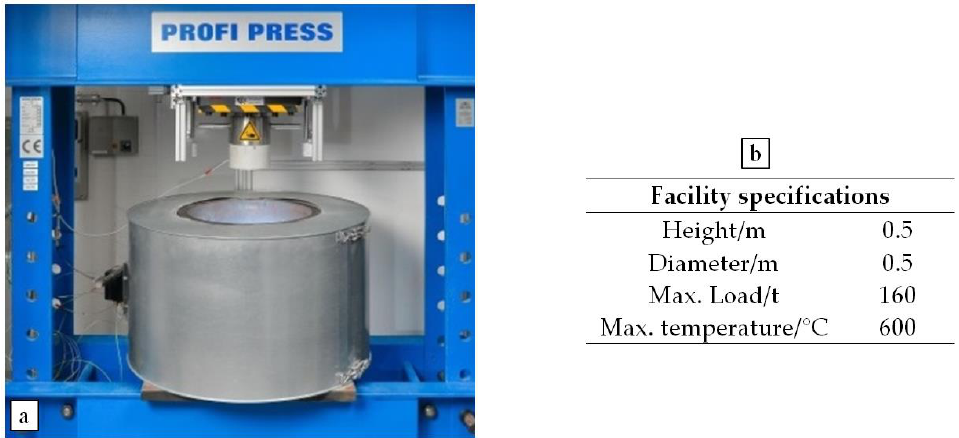
Figure 6. Uniaxial compression test rig ( a ) and its specifications ( b ).